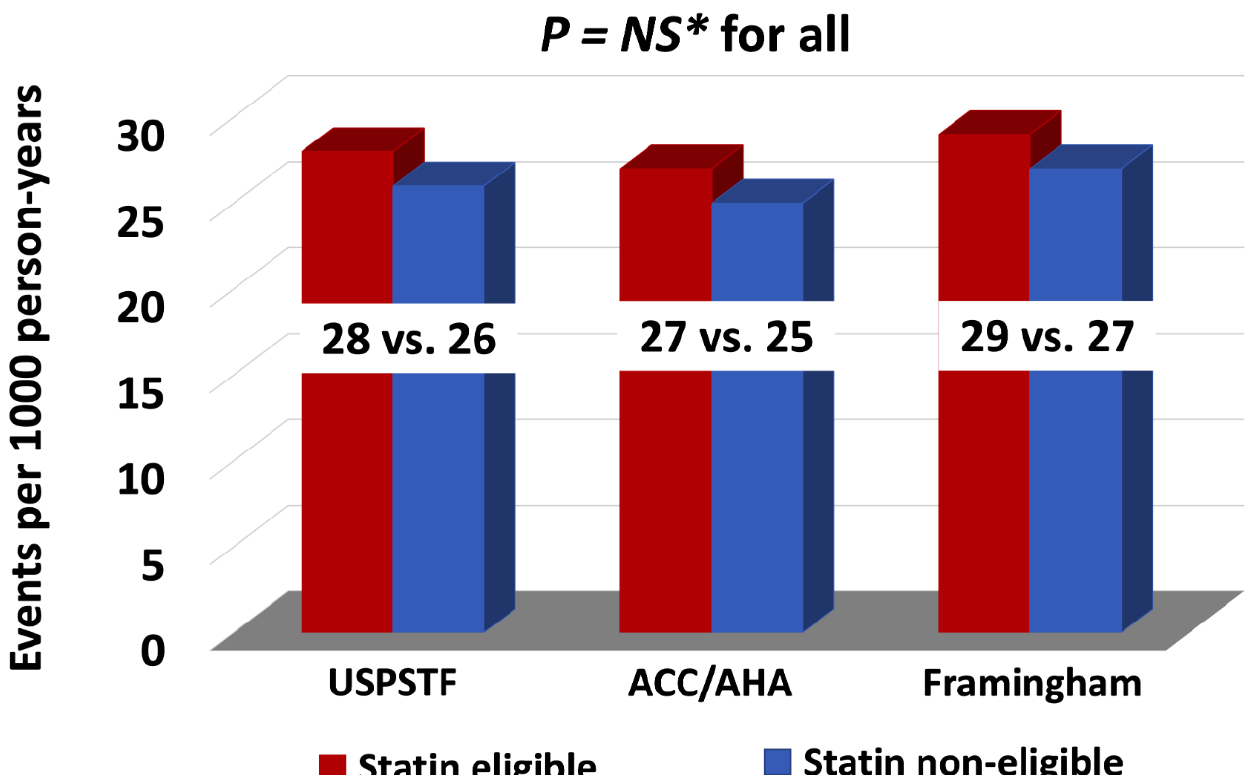
Figure 4. This figure shows bar graphs comparing the event rates between the statin eligible vs. statin non-eligible groups based on USPSTF, ACC/AHA, and FRS; and reduced discrimatory predictive power for ASCVD-risk following radiothearpy. ASCVD = Atherosclerotic Cardiovascular Disease. * NS = Statistically nonsignificant (> 0.05).